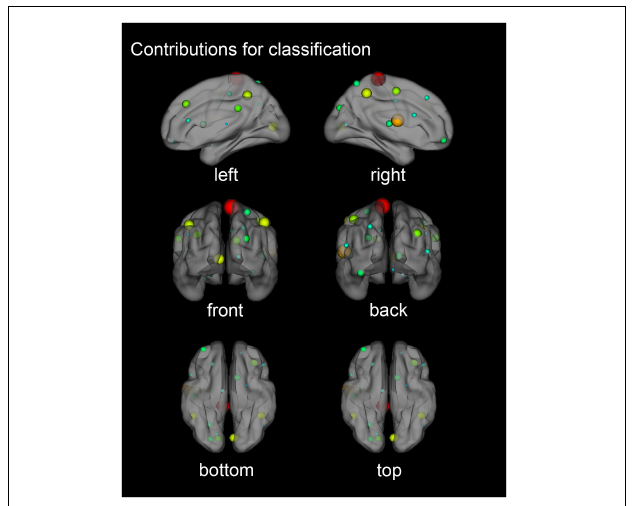
FIGURE 5 | Three-dimensional contribution of brain regions for classification. Each node represented a brain region divided by AAL90 (Anatomical Automatic Labeling template). The node colors represent different regions and the node size was scaled according to the weight value of the brain regions. The greater the contribution of the brain region, the larger the radius of the